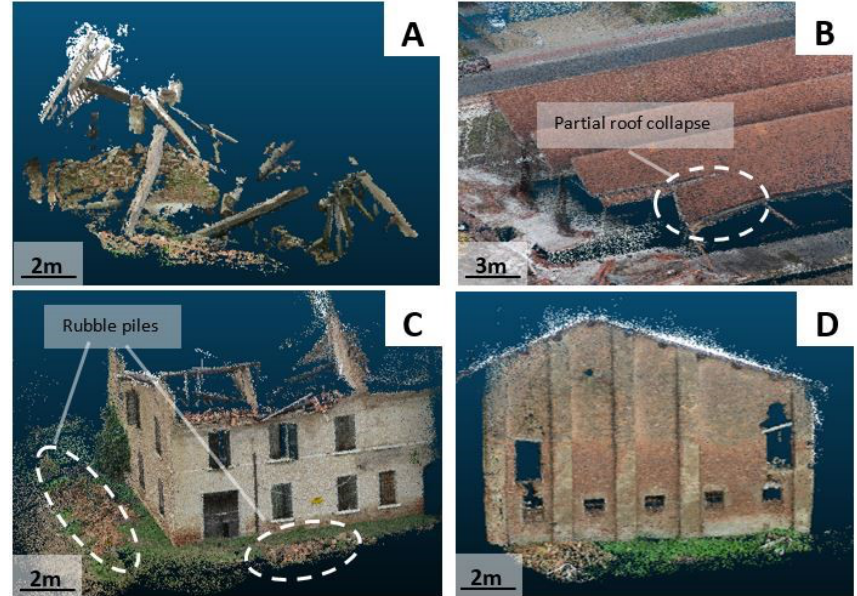
Figure 3. The 3-D point clouds used to identify the mentioned damage features. (a) Total collapse (Italy: pole-based), (b) partly collapsed roof (Germany: UAV-based), (c) rubble pile (Italy: pole-based), and (d) frontal view of an inclined wall (Italy: pole-based). Scale